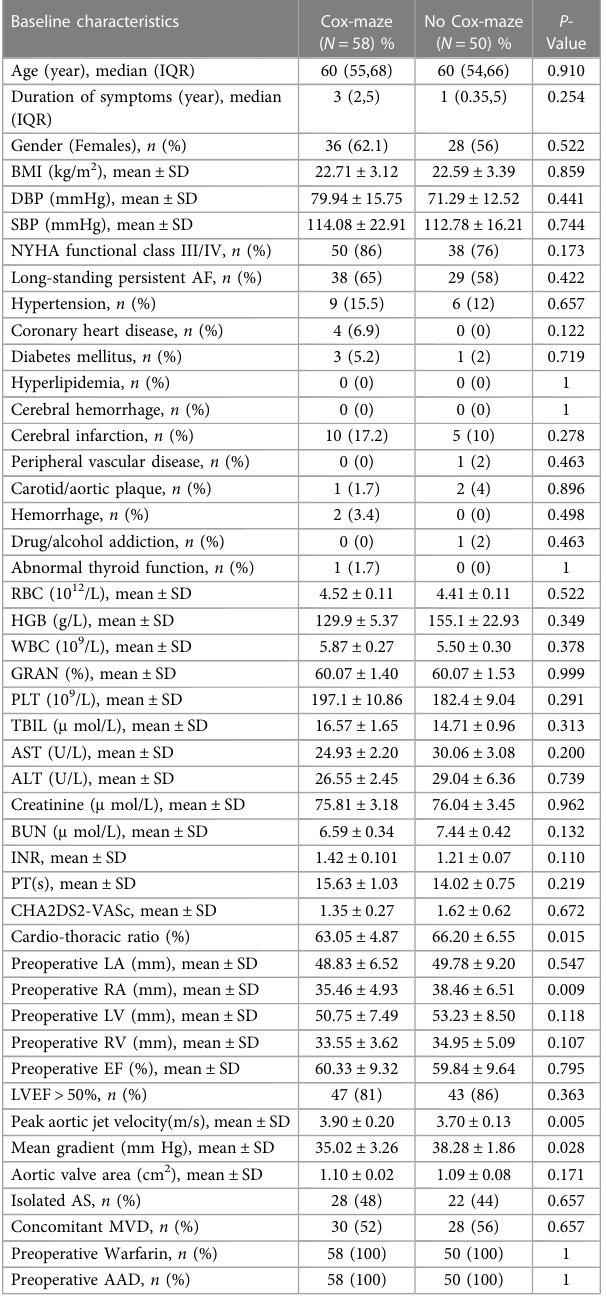
TABLE 1 Baseline characteristics between two groups. TABLE 2 Comparison of perioperative characteristics between two